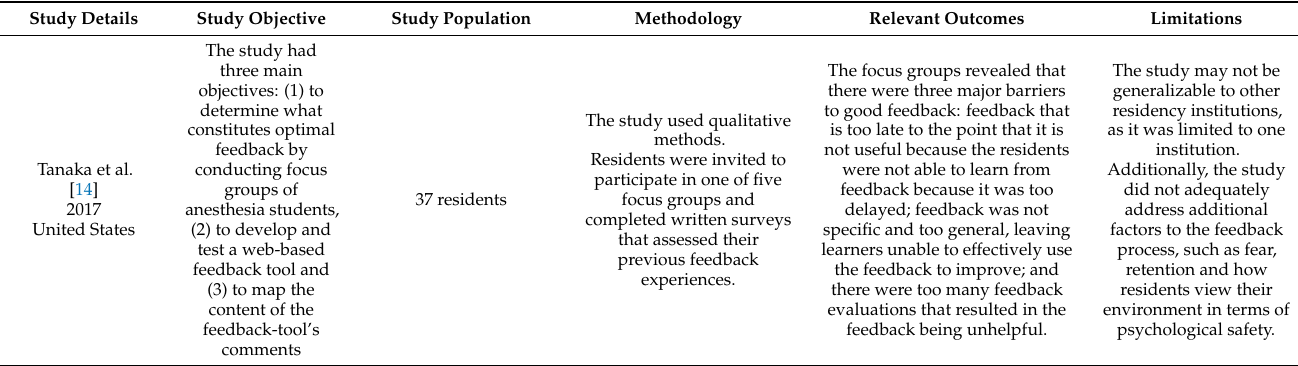
Table A2. Data extraction from selected